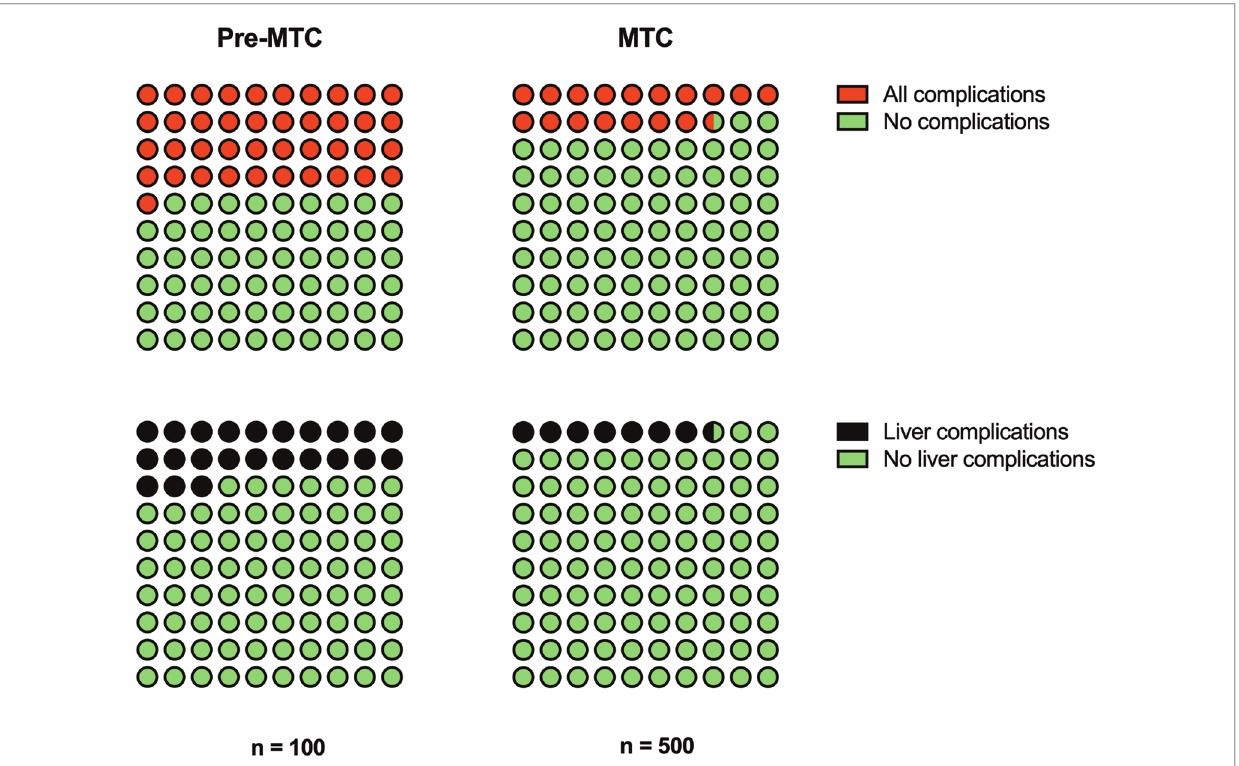
FIGURE 1 Proportion of patients who had any complications and liver-speci fi c complications compared between the pre-MTC and MTC study periods.